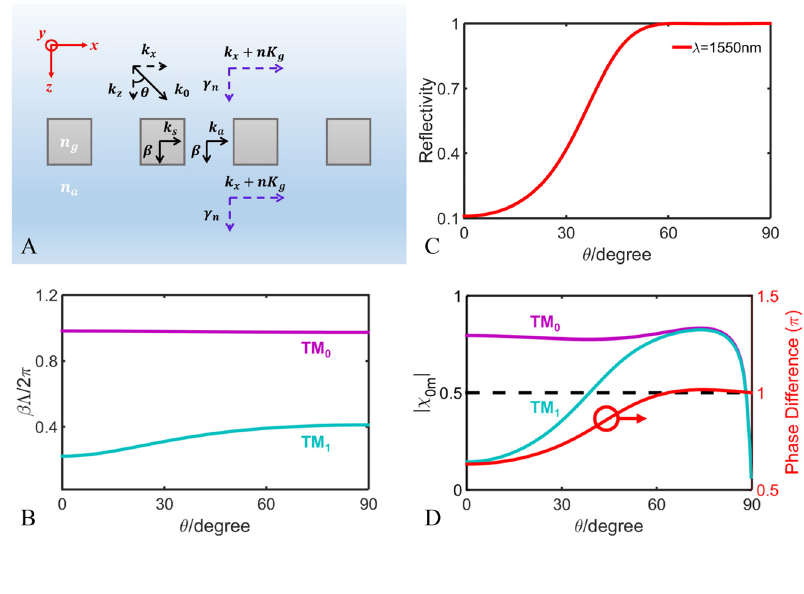
Figure 2: Waveguide array mode expansion and wide-angle high reflectance of single- layer meta-grating (MG) at a given working